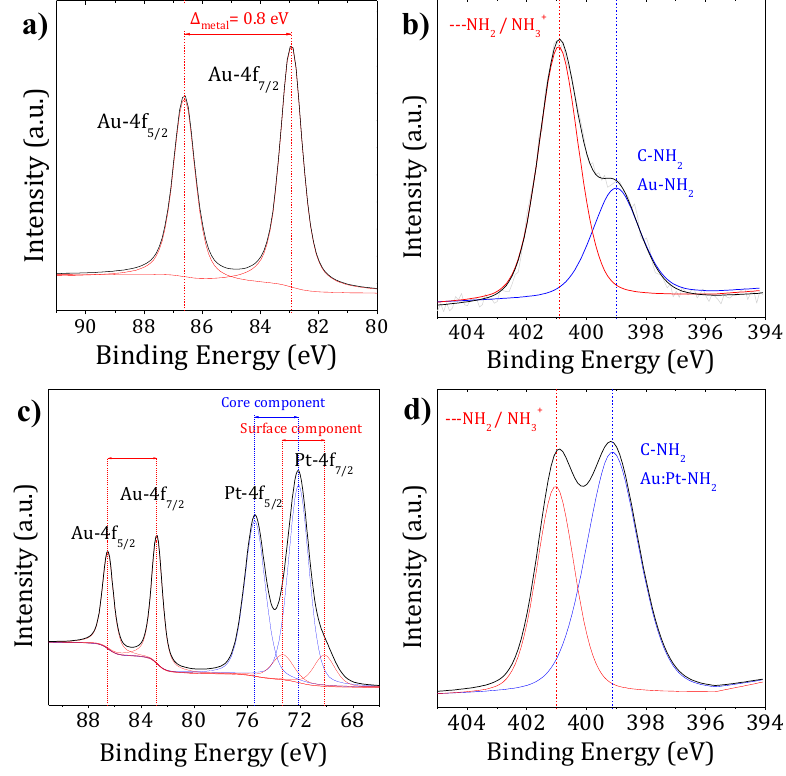
Figure 3. XPS spectra of Au-PEG NPs ( a , b ) and Au:Pt-PEG NPs ( c , d ) in the regions of Au and Pt-4f binding energies ( a , c ) and N-1s binding energies ( b , d ).